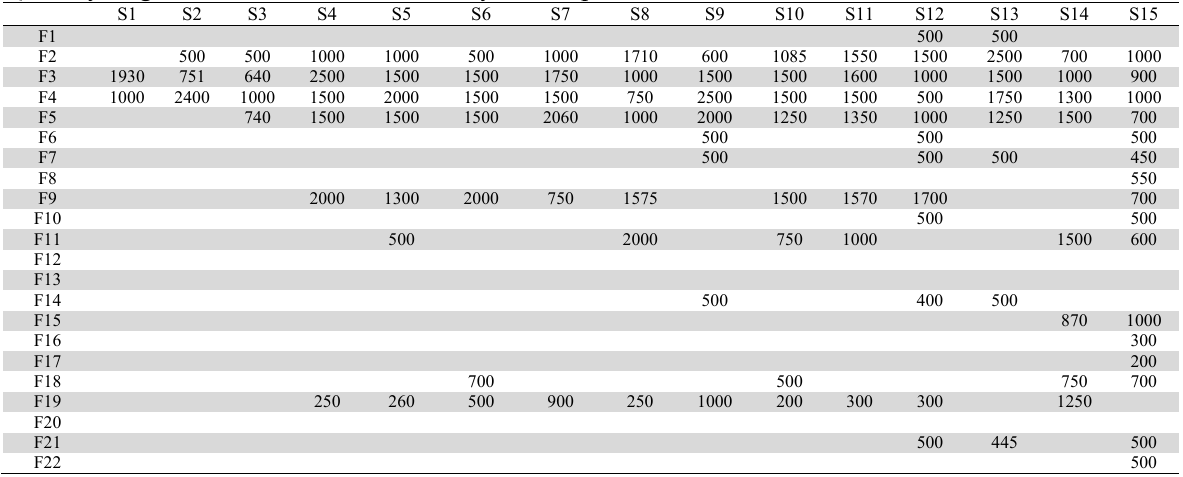
Quantity of gathered bloods in each facility at first period under each scenario S1